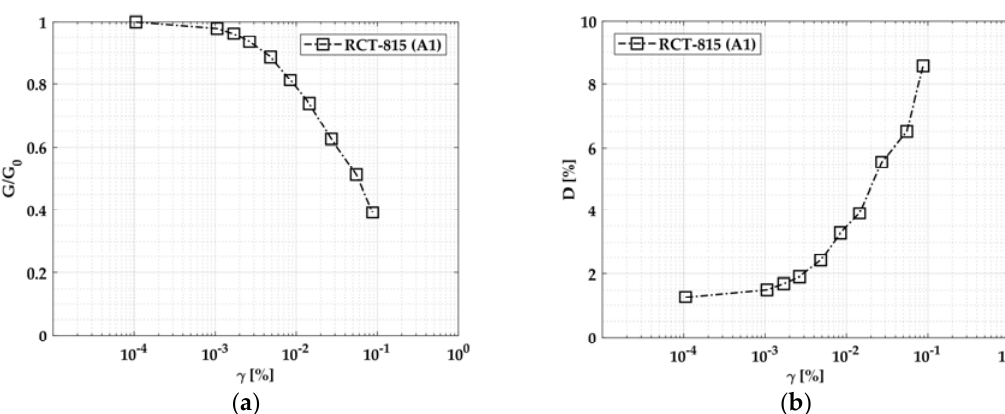
Figure 9. Resonant column test (RCT-815; 815 is the registration number of the soil sample) results (lithotype A1): ( a ) modulus reduction curve; ( b ) damping ratio.